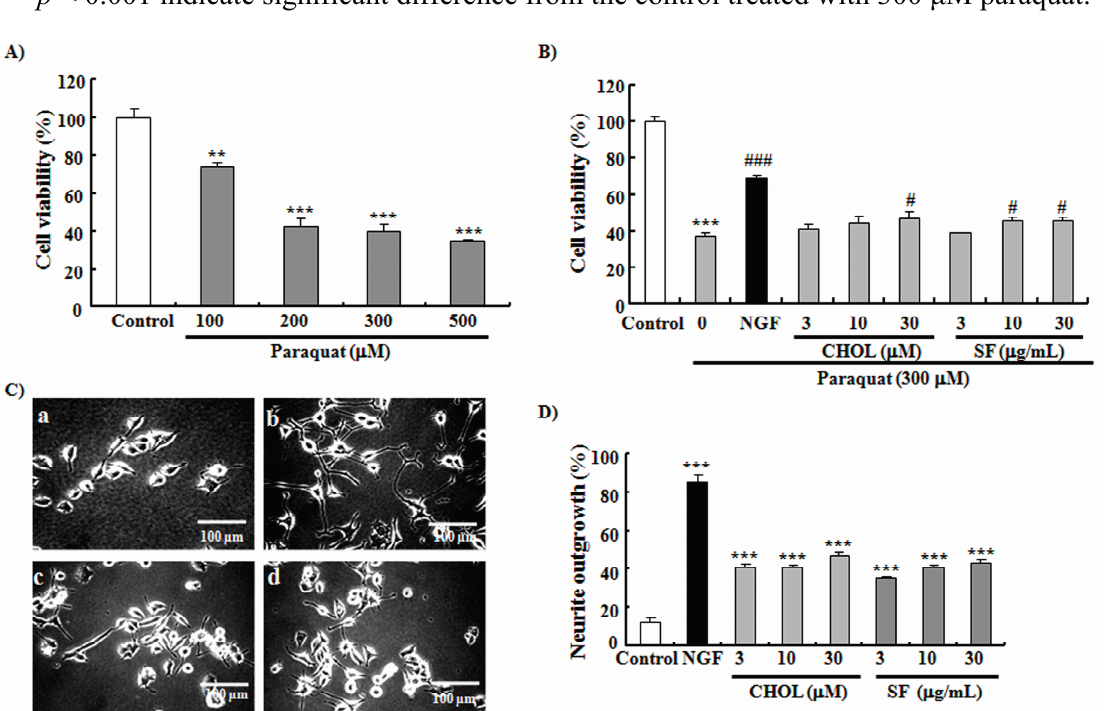
Figure 5. Neuroprotective effects of CHOL and SF. ( A ) The dose-dependent investigation of paraquat. The cell viability of the control group was 100.0% ± 4.4%; 100 μ M paraquat, 73.4% ± 3.1%; 200 μ M paraquat, 41.9% ± 4.6%; 300 μ M paraquat, 39.6% ± 3.8%; 500 μ M paraquat, 34.9% ± 0.4%; ( B ) Effects of SF and CHOL on survival viability of PC12 cells under oxidative stress induced by 300 μ M paraquat. Control: 0.5% DMSO; NGF: positive control, 40 ng/mL. The cell viability in the control group was 100.0% ± 3.0%; the control group treated with 300 μ M paraquat, 37.9% ± 1.7%; NGF, 69.5% ± 1.4%; CHOL at 3 μ M, 41.5% ± 2.6%; CHOL at 10 μ M, 44.7% ± 4.1%; CHOL at 30 μ M, 46.8% ± 4.5%; SF at 3 μ g/mL, 39.0% ± 0.4%; SF at 10 μ g/mL, 45.9% ± 1.9%; SF at 30 μ g/mL, 45.5% ± 2.4%; ( C ) Photomicrographs of PC12 cells after treatment with SF and CHOL: (a) Solvent control (0.5% DMSO), (b) NGF (40 ng/mL), (c) CHOL (30 μ M), and (d) SF (30 μ g/mL); ( D ) Percentage of neurite outgrowth of PC12 cells treated with 3, 10, or 30 μ M CHOL or 3, 10, or 30 μ g/mL SF. The percentage of neurite outgrowth of PC12 cells in the control group was 13% ± 1.8%; NGF, 85% ± 3.7%; SF at 3 μ g/mL, 35% ± 1.2%; SF at 10 μ g/mL, 41% ± 1.2%; SF at 30 μ g/mL, 43% ± 1.2%; CHOL at 3 μ M, 41% ± 2.0%; CHOL at 10 μ M, 41% ± 1.2%; CHOL at 30 μ M, 47% ± 2.1%. Each experiment was conducted at least three times. Vertical bars represent the mean SEM of three assays. ** p < 0.01, and *** p < 0.001 indicate statistically significant difference from the corresponding control. # p < 0.05 and ### p < 0.001 indicate significant difference from the control treated with 300 μ M